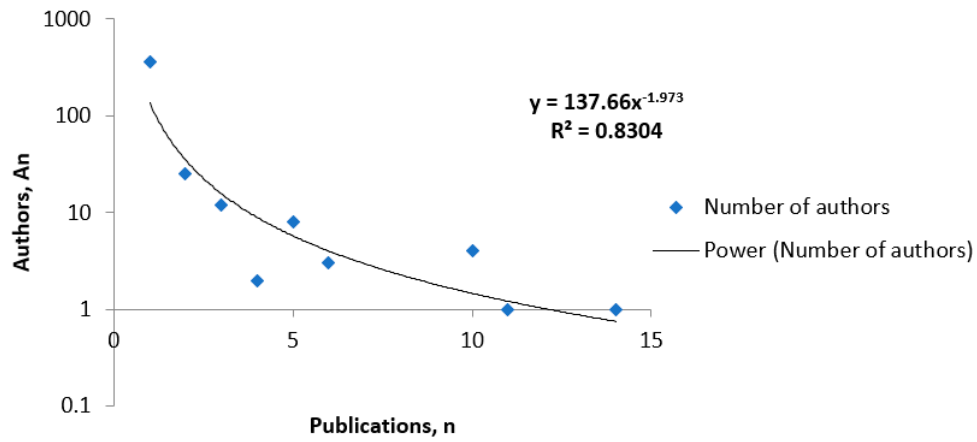
Figure 4. Distribution of Lotka’s law of productivity of authors. Table 3. Distribution of authors by productivity level.